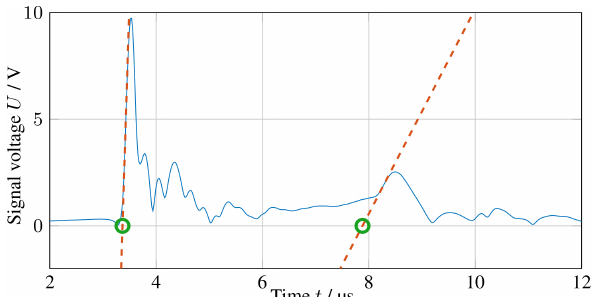
Figure 7. Envelope of the signal measured with the excitation lo- cated directly below the transducer (solid). With tangents (dashed) in the inflection points before the maxima to estimate the arrival of the longitudinal and transversal